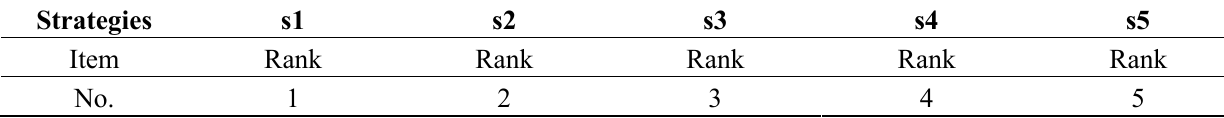
Table 14. Evaluations of the architectural